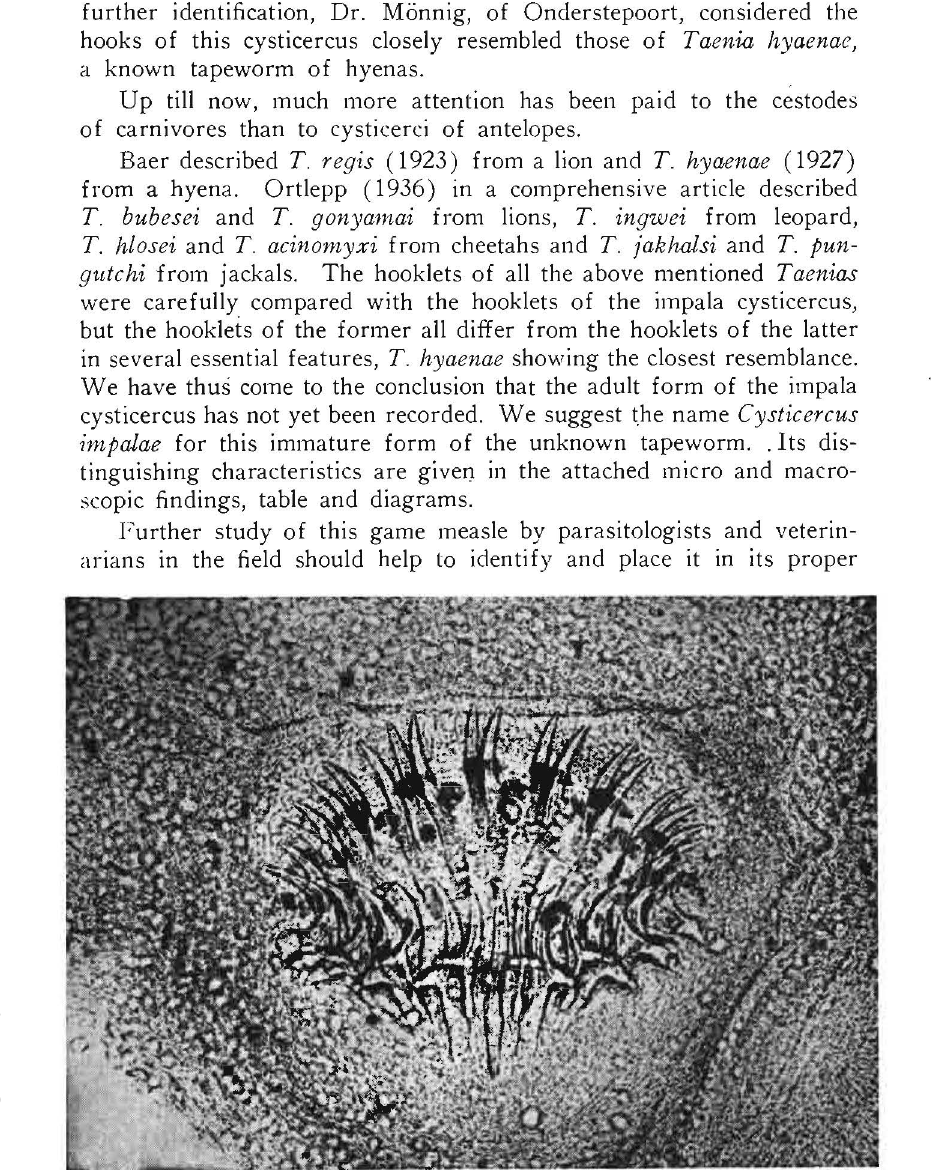
Fig. IV. - Photomicrograph of a complete head of the cysticC1"cuS of the i1npala, crusheq, but not stained, showing the hooklets. (X 180). zoological relationship to the natural